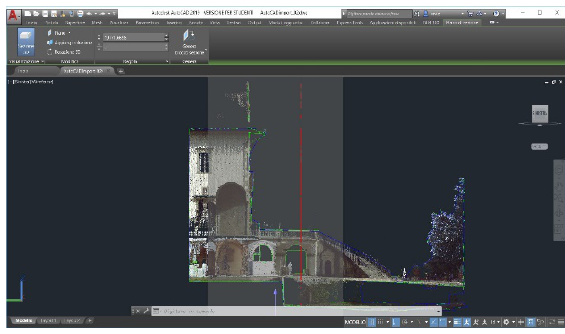
Figure 2: line generation in